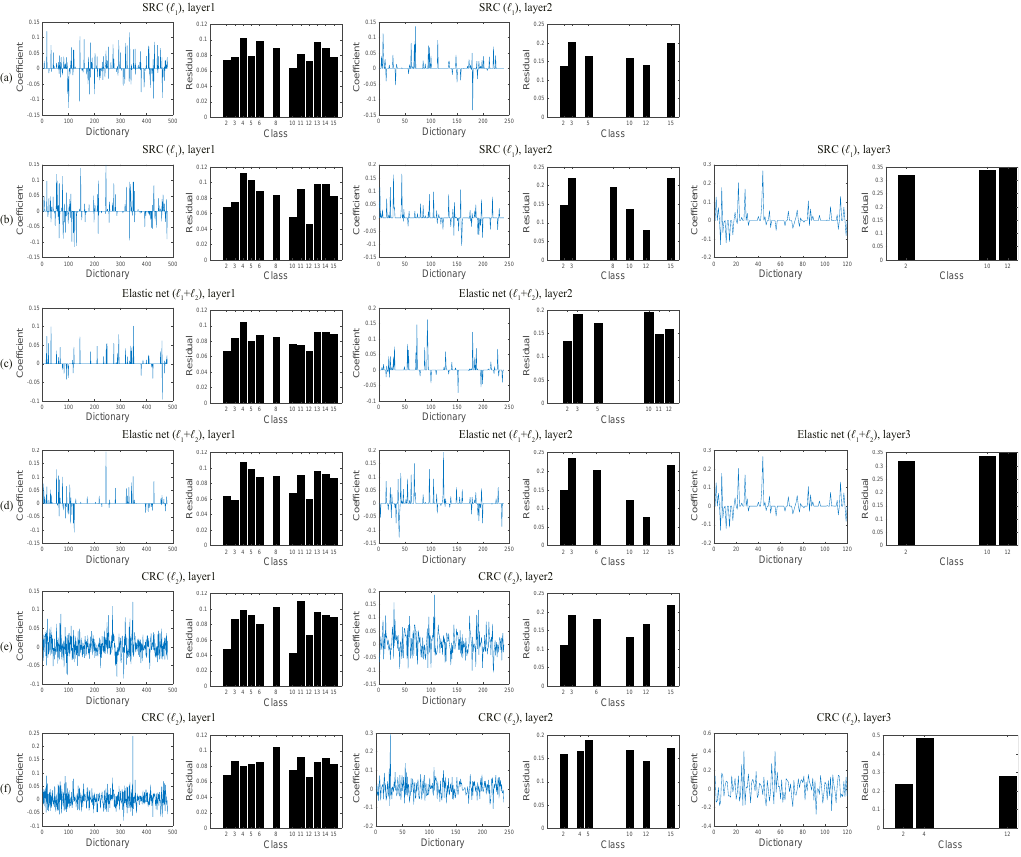
Figure 1. Estimated assignment distributions (sparse coefficient and residual) for the pixels from Class 2 in the Indian Pines image. ( a ) Sparse representation classification (SRC) ( ℓ 1) for pixel (21, 6); ( b ) SRC ( ℓ 1) for pixel (25, 7); ( c ) elastic net ( ℓ 1 + ℓ 2) for pixel (21, 6); ( d ) elastic net ( ℓ 1 + ℓ 2) for pixel (25, 7); ( e ) collaborative representation classification (CRC) ( ℓ 2) for pixel (18, 13); and ( f ) CRC ( ℓ 2) for pixel (18, 6).